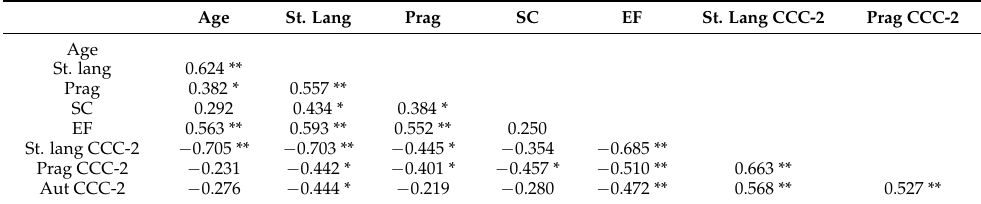
Table 4. Zero-order nonparametric Spearman correlations between formal measures and Children’s Communication Checklist-2 (CCC-2) scores within the Developmental Language Disorder (DLD) group ( n =